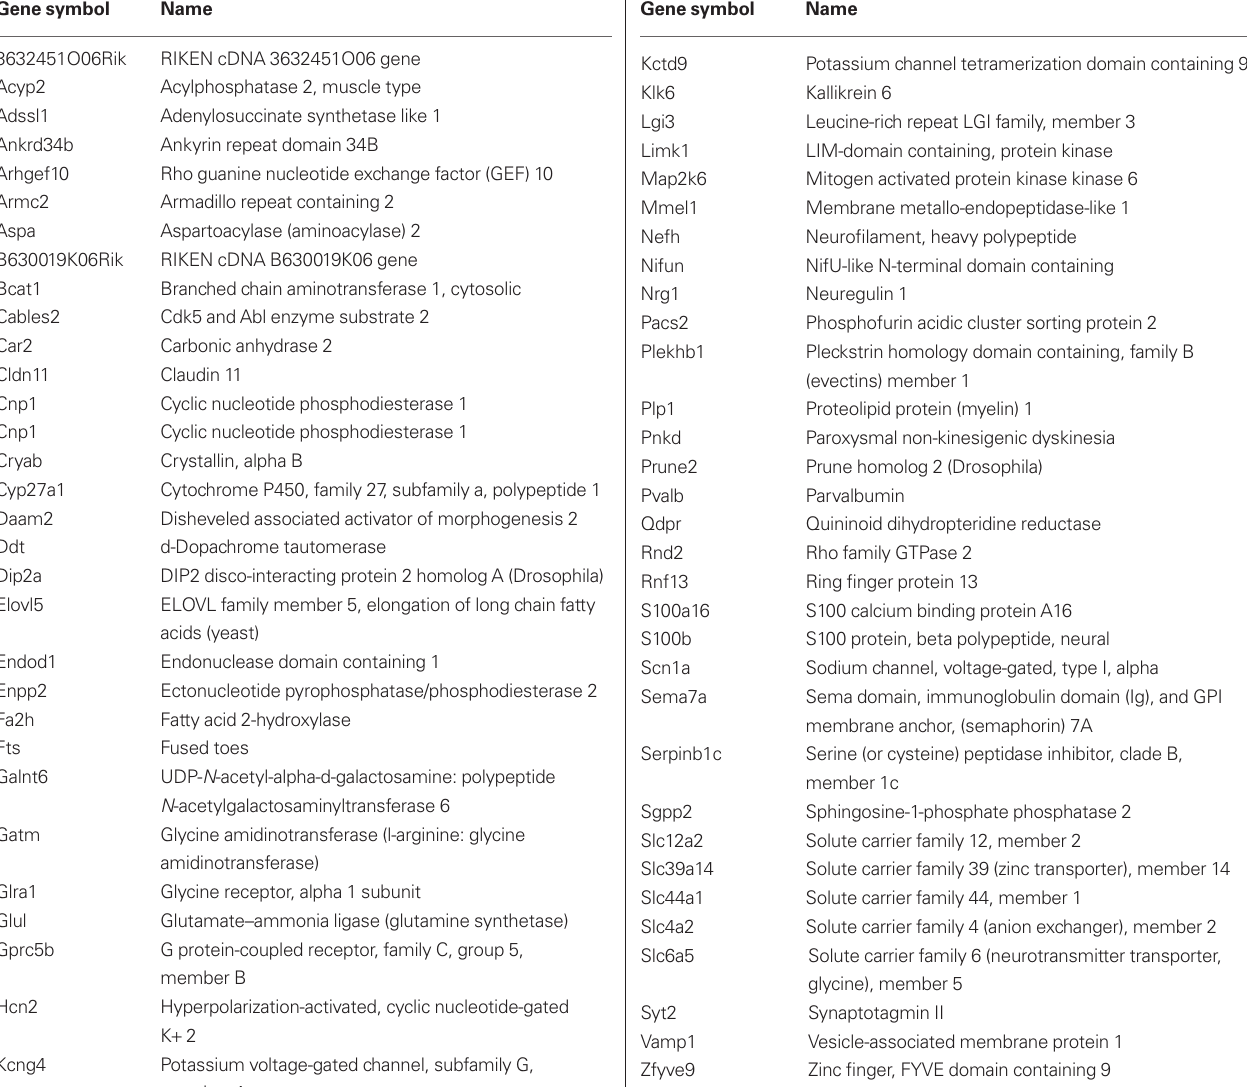
Table 2 | Pattern Oe gene symbols and